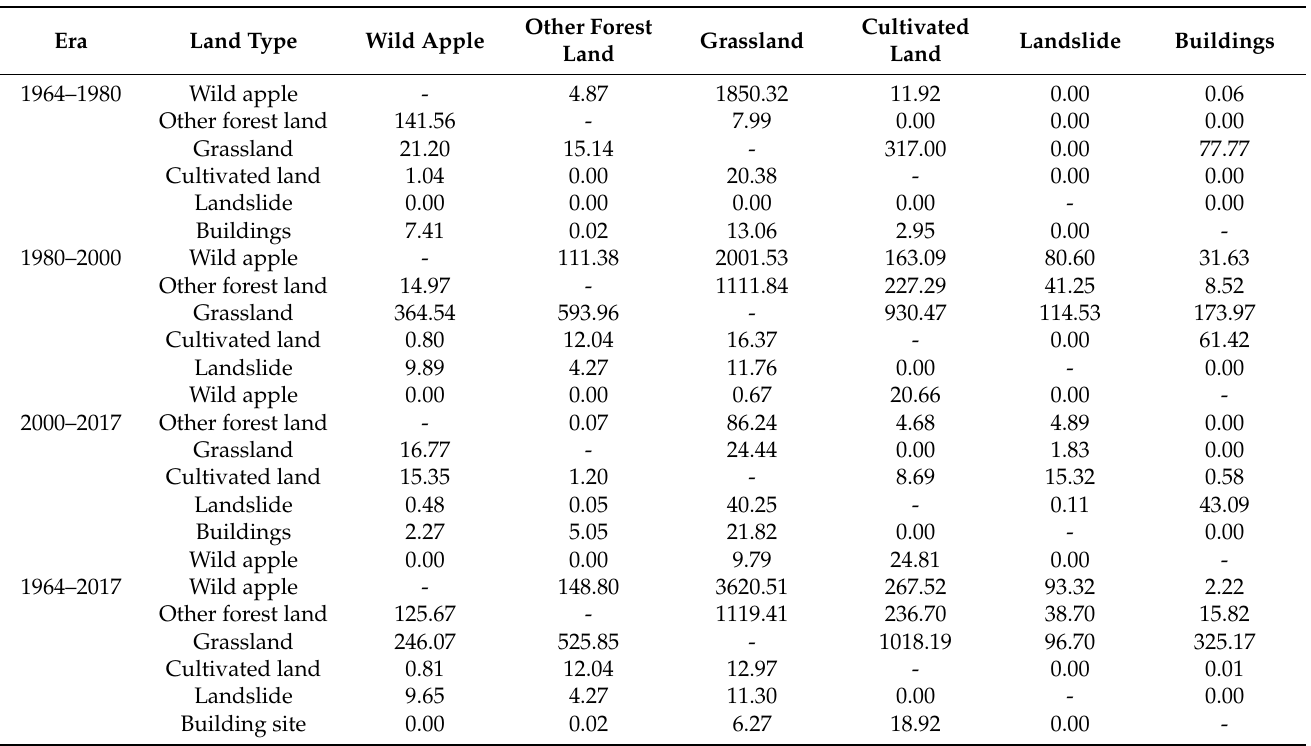
Table 9. Area transfer matrix of landscape types from 1964 to 2017 in Mohe Watershed (hm 2 ).